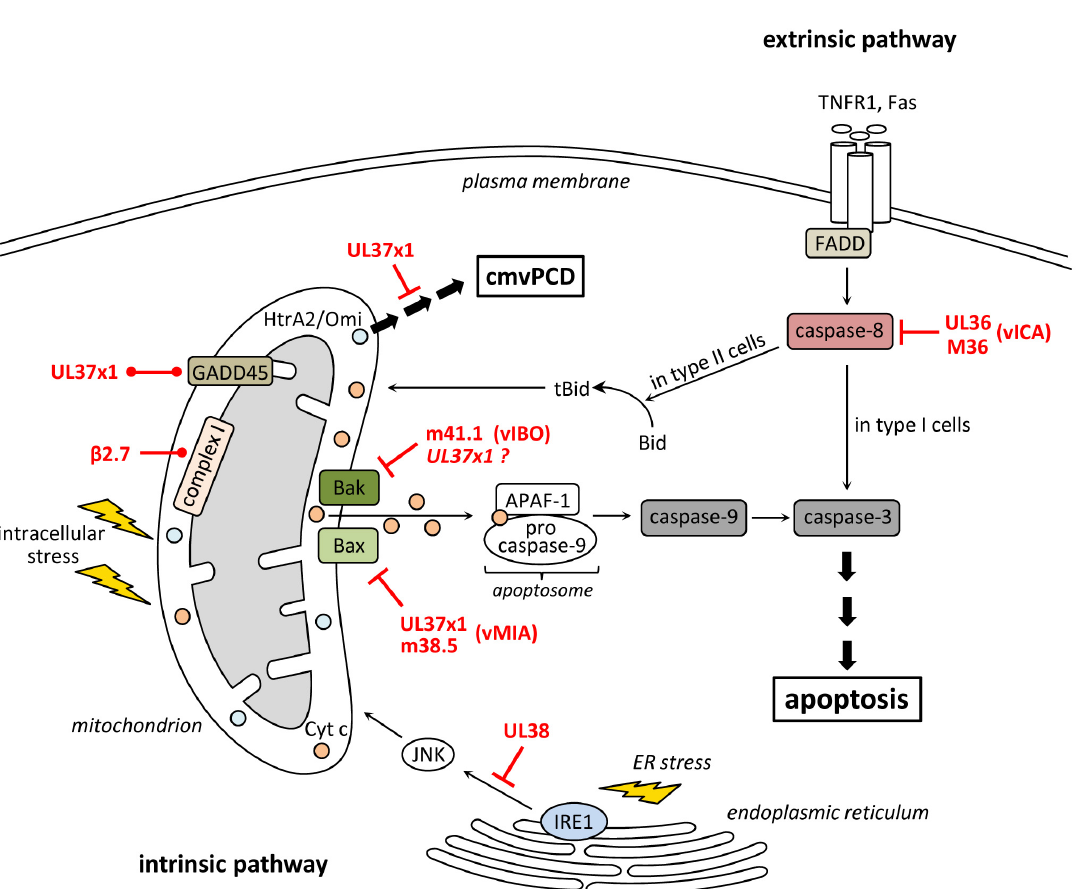
Figure 1. Inhibition of apoptosis and cmvPCD by human and murine cytomegalovirus (CMV). Ligation of death receptors (e.g., TNFR1 or Fas) leads to the activation of caspase-8, which directly activates caspase-3 (in type I cells) or cleaves Bid to tBid (in type II cells) inducing a mitochondrial signal amplification through the release of cyt c ,